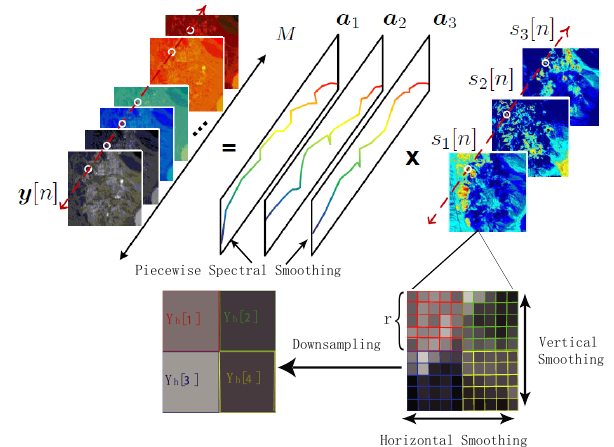
Figure 1. Diagram of LMM and spatial degradation matrix G with the parameter g ∈ R 25 ( r =